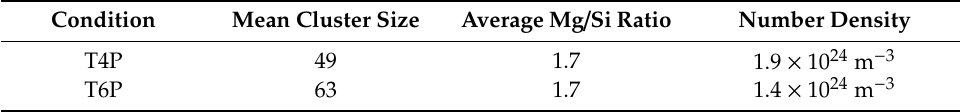
Table 4. Properties of the Mg–Si clusters of Alloy Zn in T4P and T6P conditions. Table 4 . Properties of the Mg–Si clusters of Alloy Zn in T4P and T6P conditions.